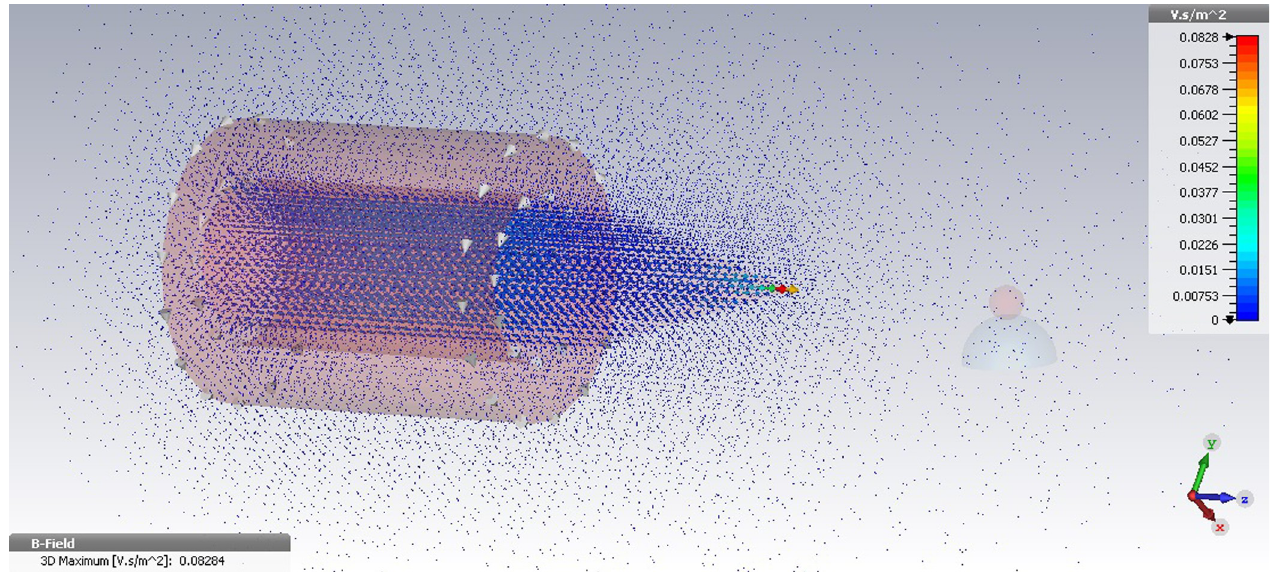
Fig 3. The 3D image of magnetic field simulation for the designed electromagnet equipped to a conical core tip under the applied current 3000 mA using CST.